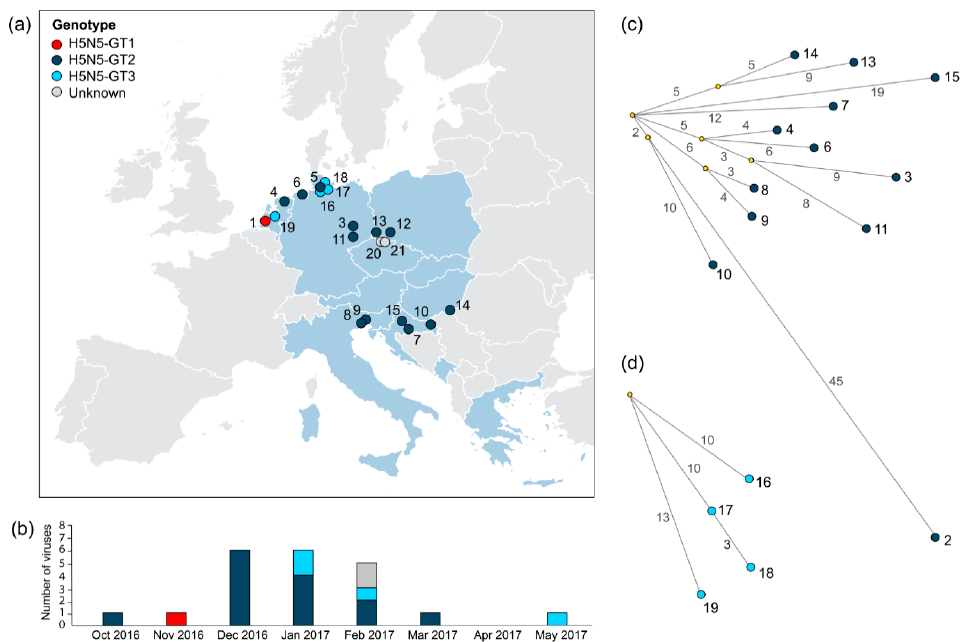
Figure 2. Spatiotemporal distribution and phylogenetic network analysis of HPAI H5N5 genotypes.